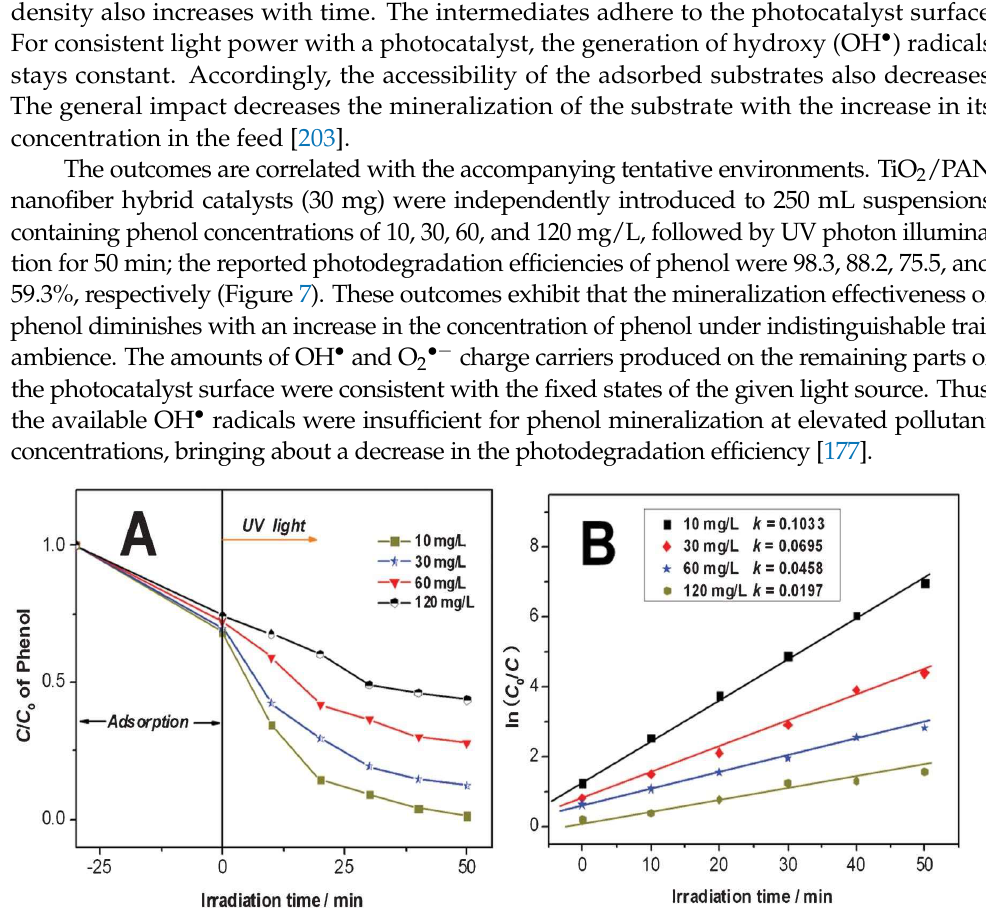
Figure 7. ( A ) Degradation profiles of various phenol concentrations over TiO 2 /PAN hybrid nanofibers. ( B ) Kinetic linear simulation curves of photocatalytic phenol degradation with different phenol concentrations. Adapted from reference [177].